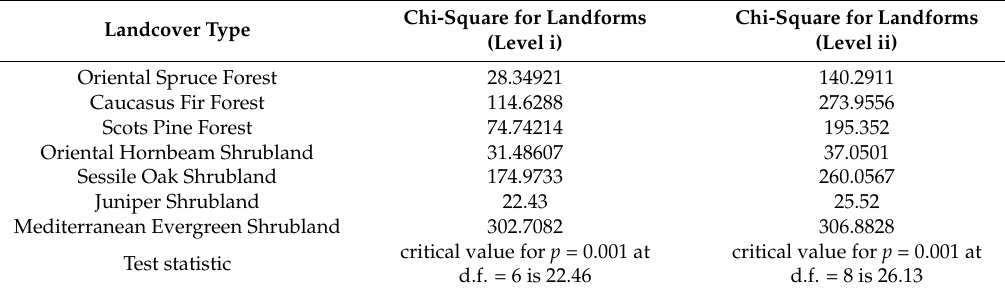
Table 2. Chi-square test for Landforms vs. landcover.